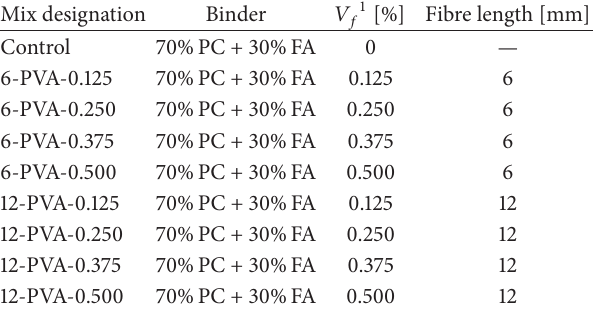
Table 3: Mix designations.